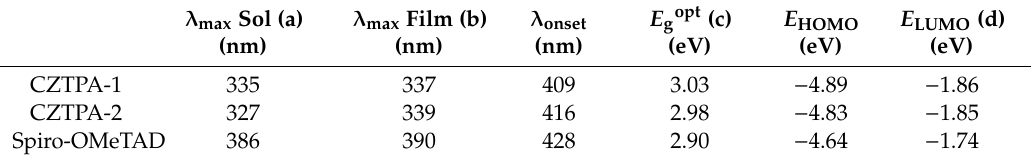
Table 1. Optical and electrochemical properties of CZTPA-1 and CZTPA-2.